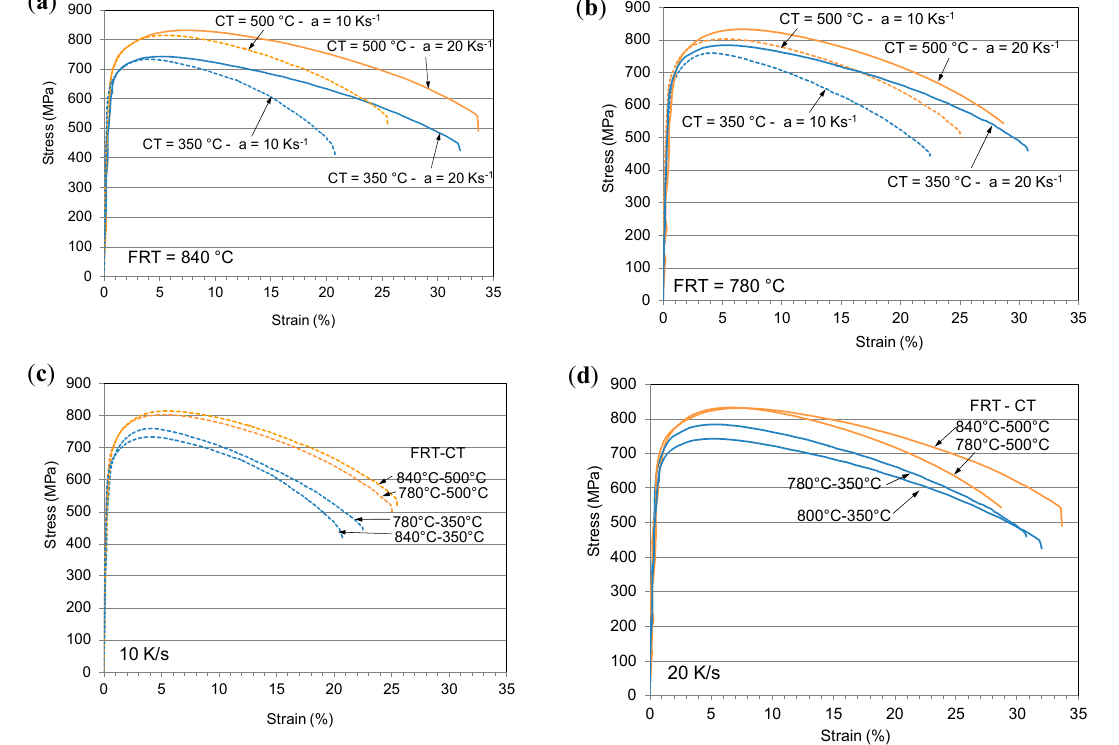
Figure 12. Stress–strain curves of samples with the prescribed TMP parameters; ( a ) FRT = 840 °C, ( b ) FRT 780 °C, ( c ) a = 10 K·s − 1 and ( d ) a = 20 K·s − 1 .